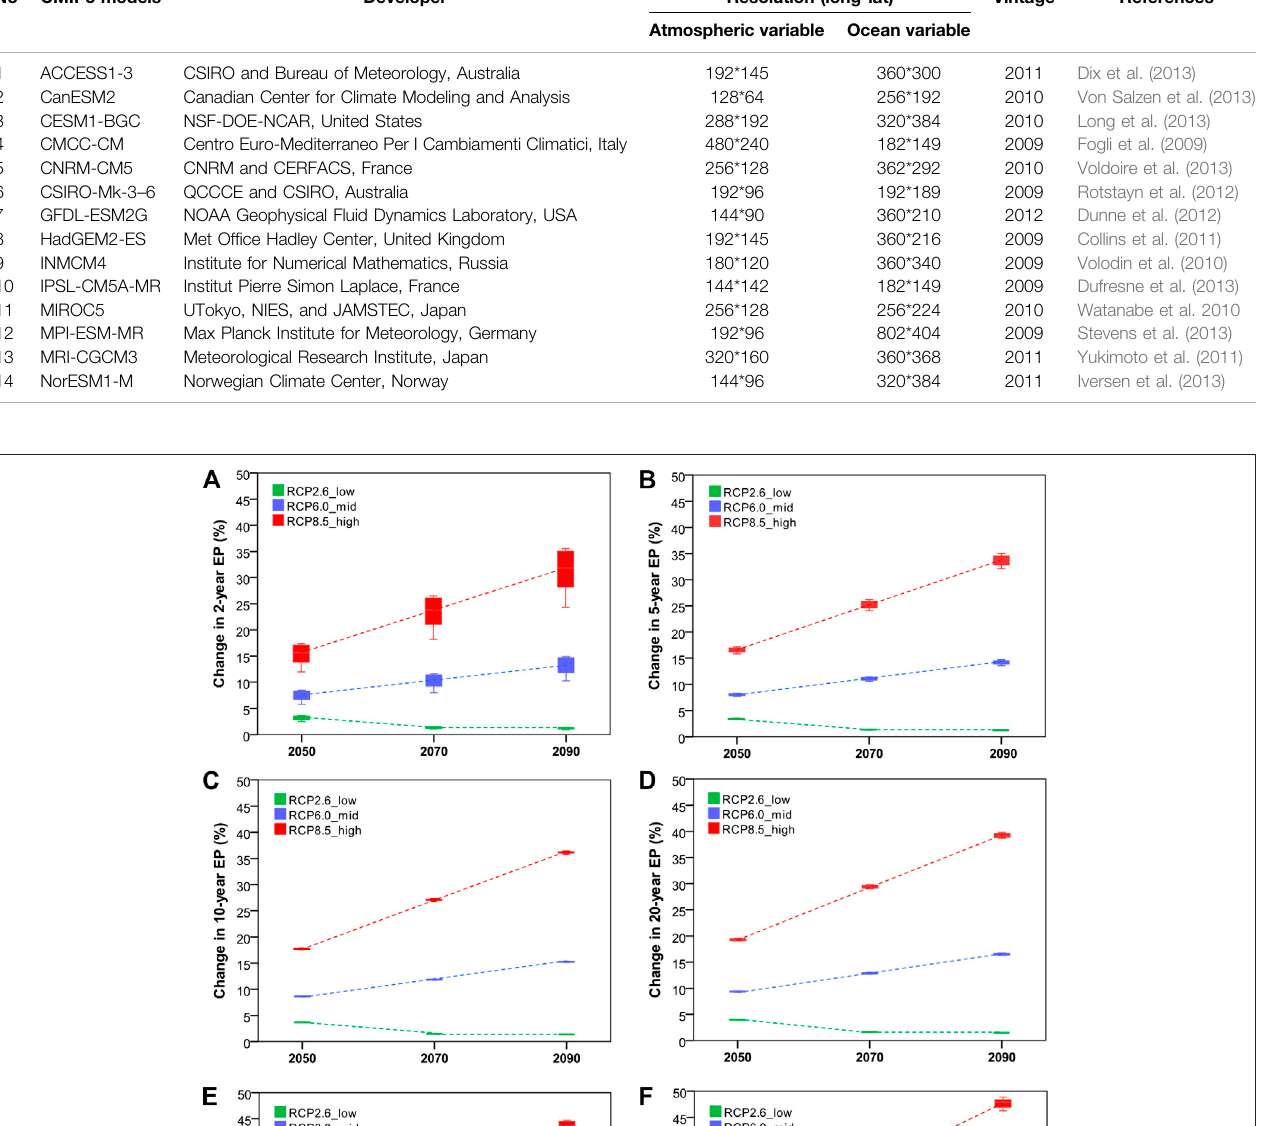
Frontiers in Earth Science |